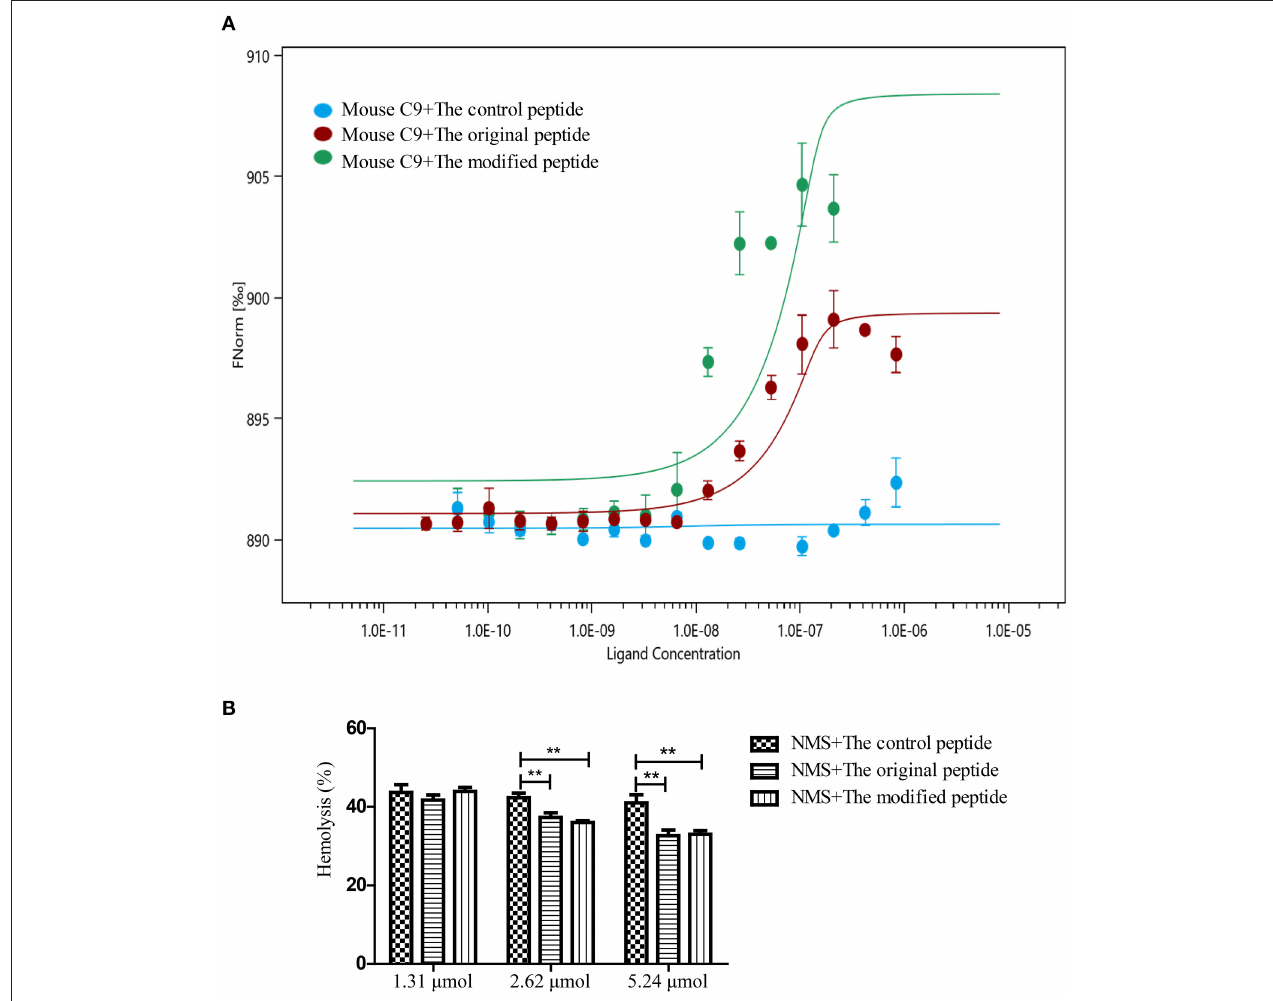
FIGURE 2 | Modified peptide bound to mouse complement C9 and inhibited normal mouse serum (NMS)-induced hemolysis of rabbit erythrocytes. (A) Microscale thermophoresis assay (NanoTemper) in which biomolecular interactions are quantitated by examining the motion of the molecules along a microscopic temperature gradient induced by an infrared laser. Changes in the molecular hydration shell, charge, or size are measured using a fluorescent probe (NT-647) bound covalently to the mouse C9. Binding of control, modified and original peptides to mouse C9 were studied. There was a concentration-dependent binding between the mouse C9 and the original or modified peptide instead of the control peptide. Data points indicate the differences in normalized fluorescence (%) generated by peptides binding to mouse C9, and curves indicate the calculated fits. Error bars represent the standard error of three independent measurements. (B) NMS-induced complement-mediated hemolysis was inhibited by the modified and original peptides (2.62 and 5.24 µ mol) compared to the control peptide. All experiments were performed three times and data are presented as mean ± SD. * p < 0.05, ** p <